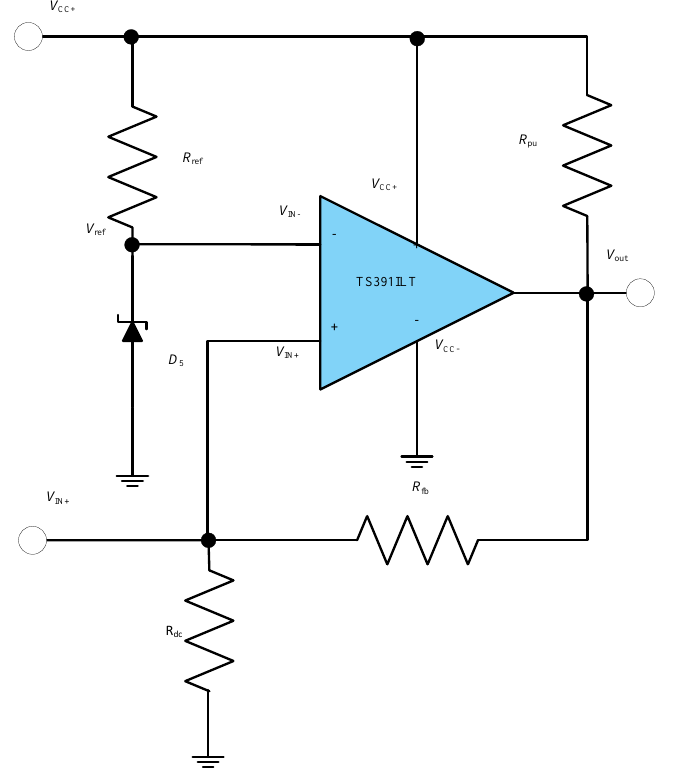
Figure 11. Circuit diagram of Schmitt Trigger